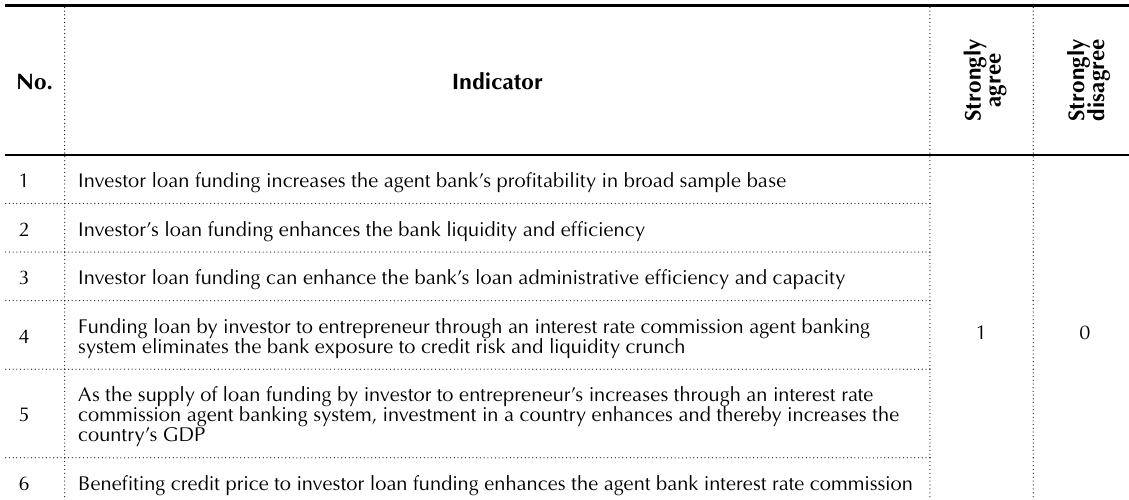
Table 2. Indicators of investor loan funding